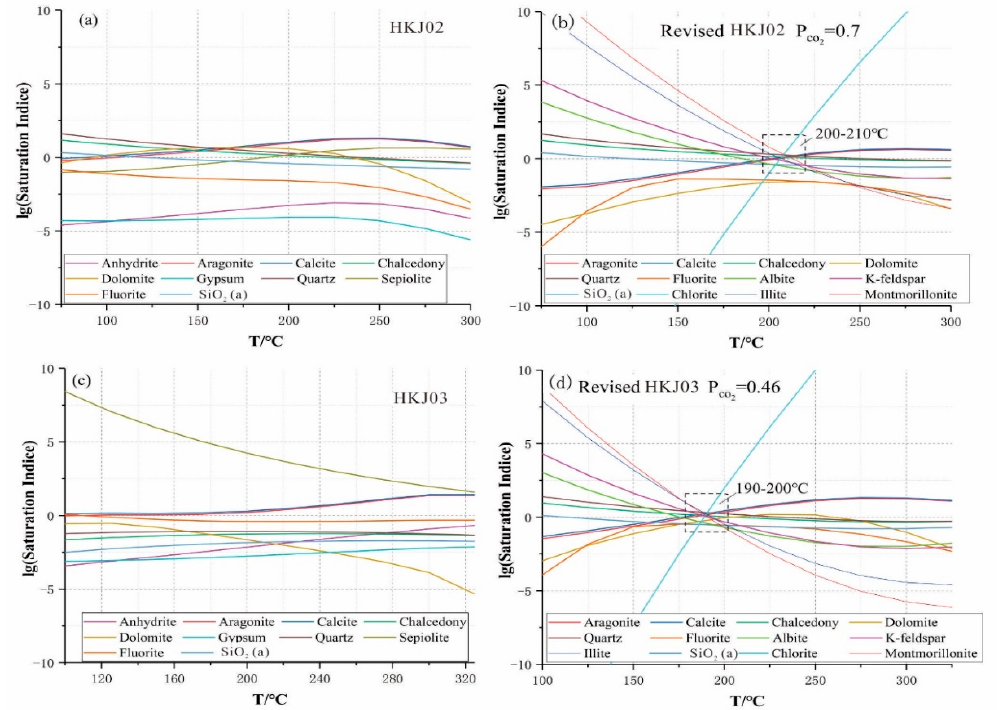
Figure 10. Initial and reconstructed mineral equilibria graph of representative drilling water samples HKJ02 ( a , b ) and HKJ03 ( c , d ).